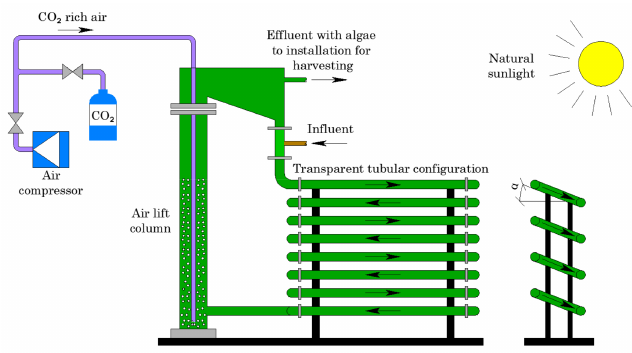
Figure 4. Enclosed tubular photobioreactor scheme adapted from Ting et al., 2017